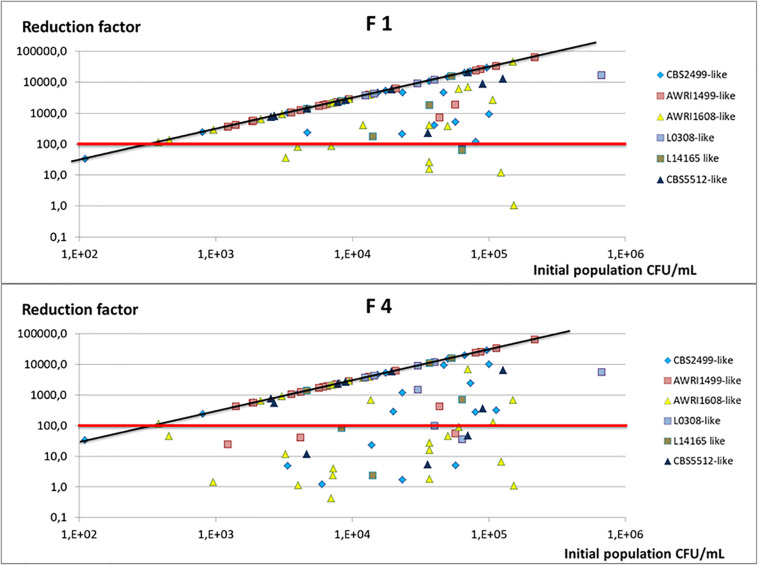
Reduction factor observed in wine A after 10 days of treatment and racking, as a function of the initial population inoculated. Each trial is represented (two points by strain) and the genetic group to which the strain studied belongs is indicated by a color code. The red line indicates the reduction factor 100 (2 log), and the black line the maximal reduction factor expected taking into account the initial population and the population detection threshold (3.33 CFU/mL).